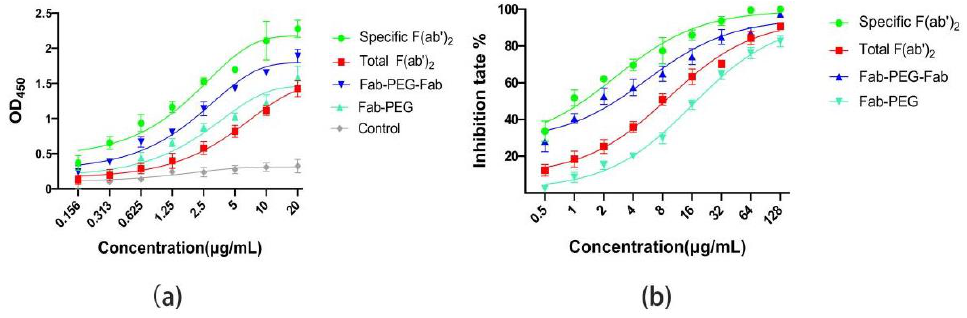
Figure 6. Comparison of the affinity and activity of specific F(ab’) 2 , PEGylated F(ab’) 2 , and total F(ab’) 2 . ( a ) The affinity of specific F(ab’) 2 , Fab-PEG-Fab, Fab-PEG, and total F(ab’) 2 measured by ELISA. ( b ) The activity of specific F(ab’) 2 , Fab-PEG-Fab, Fab-PEG, and total F(ab’) 2 measured by pseudovirus neutralization assay.